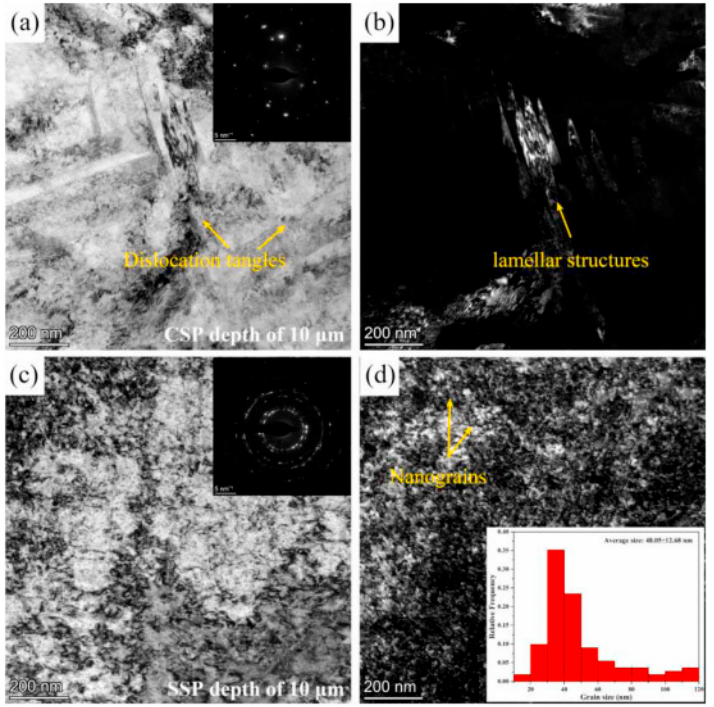
Figure 2. TEM bright field (BF) and the corresponding dark filed (DF) image from the topmost surface of treated Hastelloy X alloy: ( a , b ) SP; ( c , d ) SSP sample. Inset in Figure 2d is the statistical distribution of the grain size. Reproduced with permission from [64]. Copyright Elsevier, 2021.